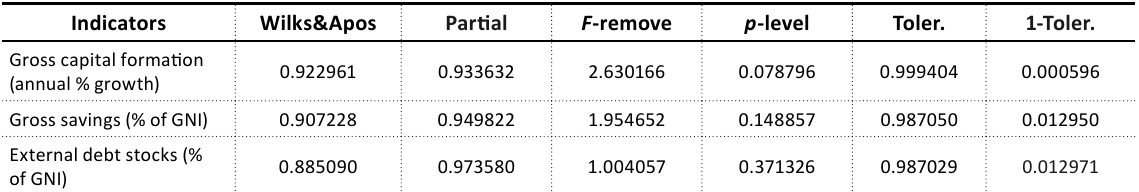
Table B1. Results of constructing a discriminant